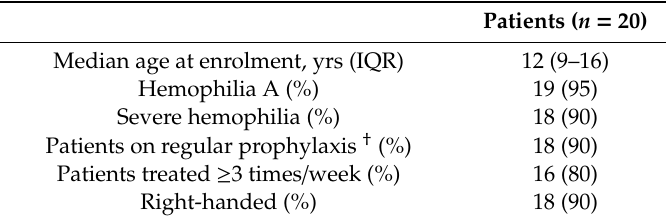
Table 1. Main characteristics of the 20 patients enrolled in the